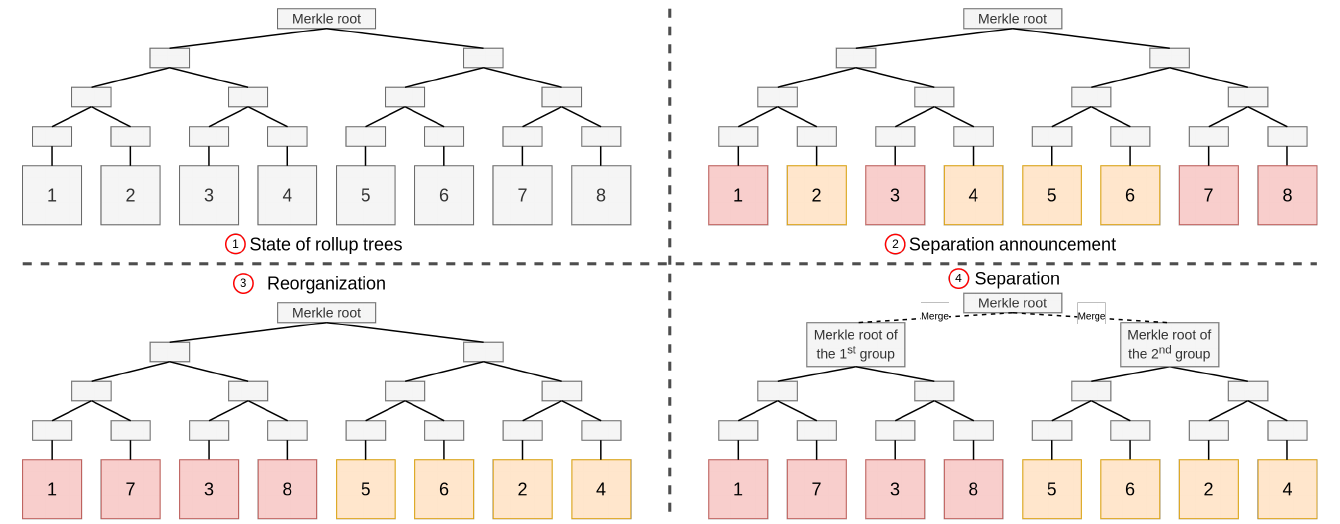
Figure 6. A separation on a